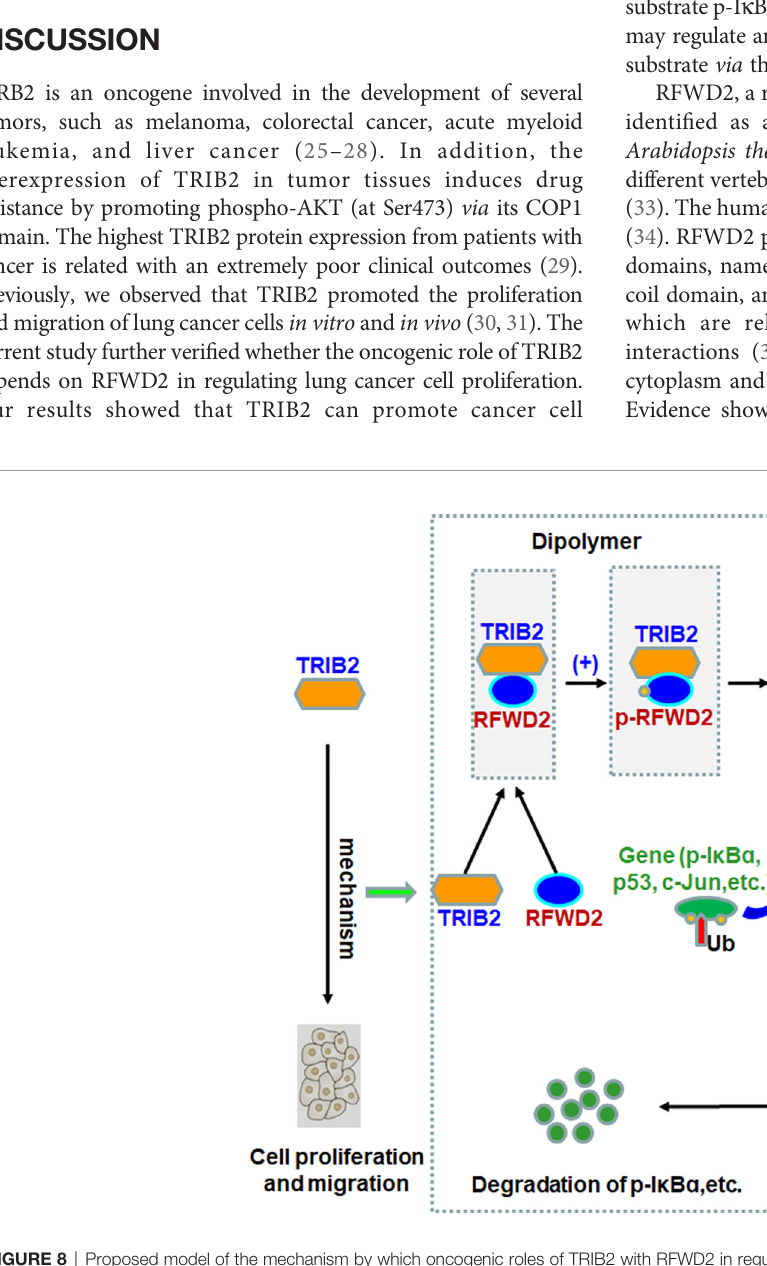
FIGURE 8 | Proposed model of the mechanism by which oncogenic roles of TRIB2 with RFWD2 in regulating proteasome-mediated degradation of